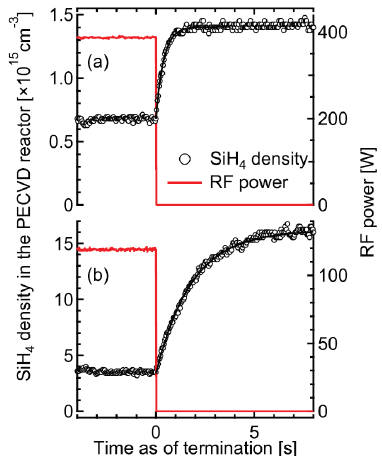
Figure 26. Plasma termination in a PECVD reactor for process A ( a ) and process B ( b ). In process A, Q SiH4 ; Q H2 , and p were 45 sccm, 1980 sccm, and 4 mbars, respectively. In process B, a pressure of 1 mbar was maintained in the reactor with a pure input SiH 4 flow rate of 120 sccm. Upon termination of the plasma, the SiH 4 recovers its undepleted value with a time constant of 390 ms ( a ) and 1.82 s ( b ) (as obtained from an exponential fitting procedure). The time constant is similar to the gas residence time of the respective process [57], Reproduced from [57], with the permission of AIP